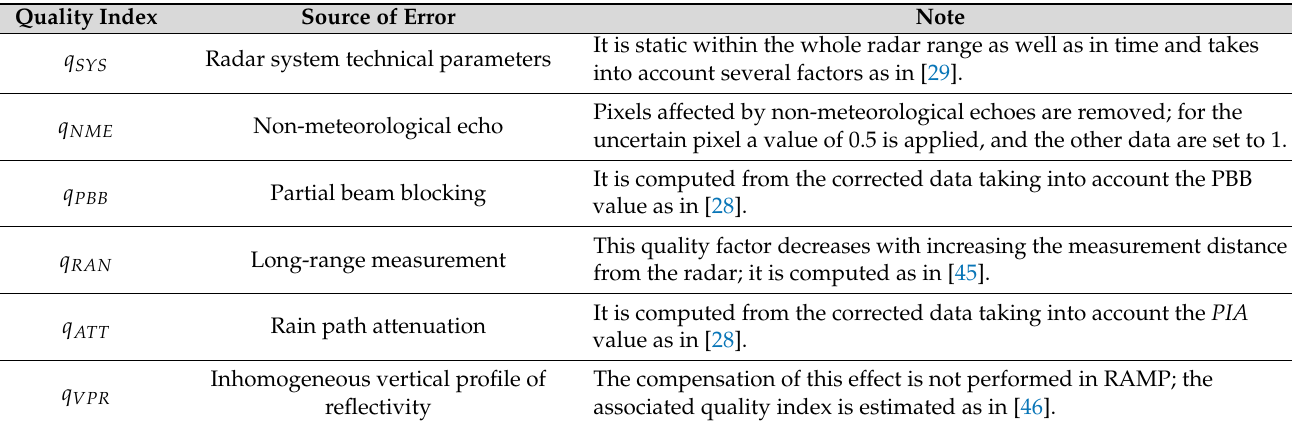
Table A1. Group of quality indices q i and related sources of